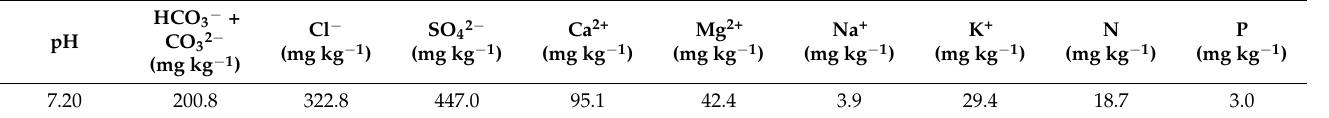
Table 1. Chemical properties of the used